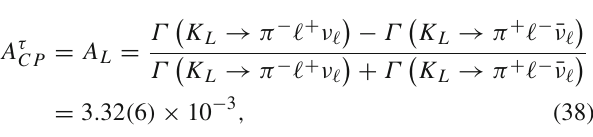
Fig. 8 Forward–backward asymmetry as defined in Eq. (34) for the four fit results as given in Table 3